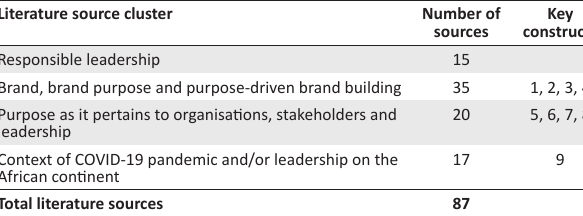
TABLE 1: Literature sources across four